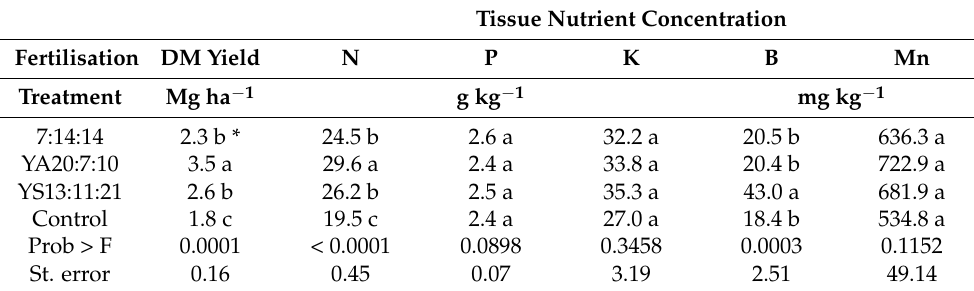
Table 7. Dry matter yield and nutrient concentrations in the herbaceous vegetation developing under the canopy of chestnut trees where the fertilisation treatments were